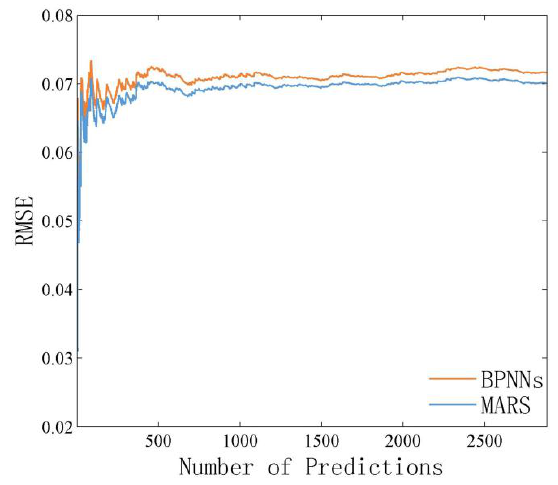
Figure 6. Performance in the test set averaged over the Landsat 7 ETM+ training-test data splitting as a function of the number of used predictions.